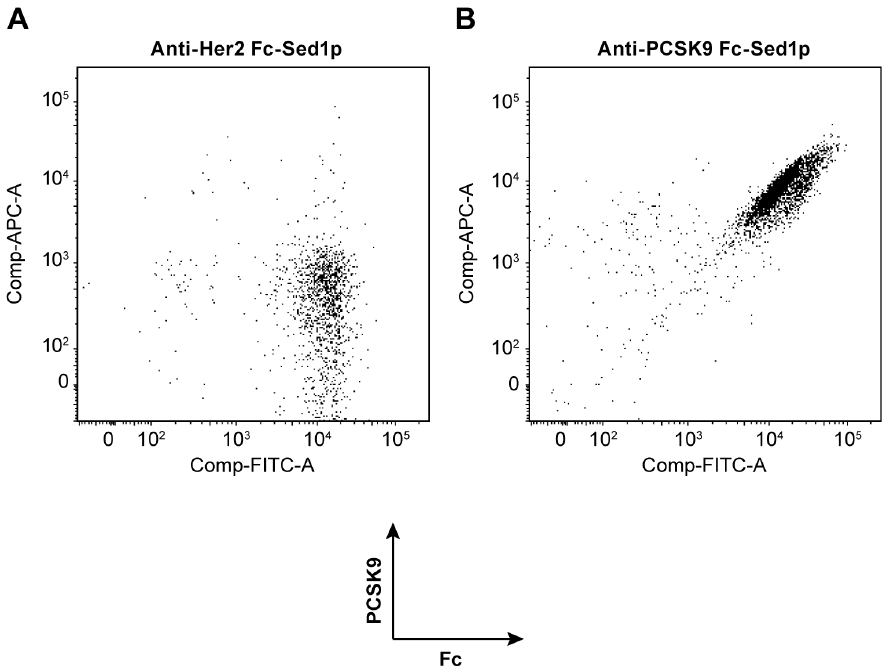
Figure 3. Antigen binding capacity of monovalent IgGs displayed by Fc-Sed1p measured by flow cytometry. The cells were dually labeled with goat anti-human Fc DyeLight 488, biotinylated PCSK9, and APC 635 labeled Streptavidin A ) FACS analysis of labeled Pichia pastoris strains displaying Fc-Sed1p complexed with monovalent anti-Her2 antibody fragment (H+L) or B ) an monovalent anti-PCSK9 (H+L) antibody